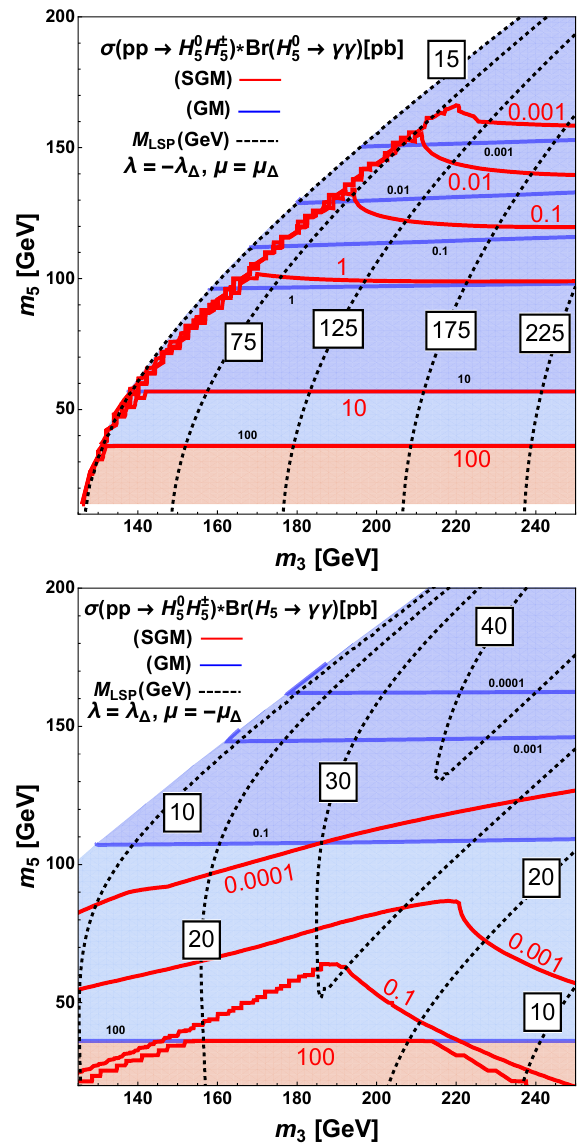
Figure 1 . Top : contours of the custodial (cid:12)veplet (pair) production cross section ( pb ) times branch- ing ratio into photons at a 13 TeV LHC. Results for the GM model (blue solid lines with background color) and SGM model (red solid line) are shown with contours of the LSP mass (black dashed lines) and inputs de(cid:12)ned for Point 1 in eq. (3.4). Bottom : same as top, but for Point 2 in eq. (3.4).